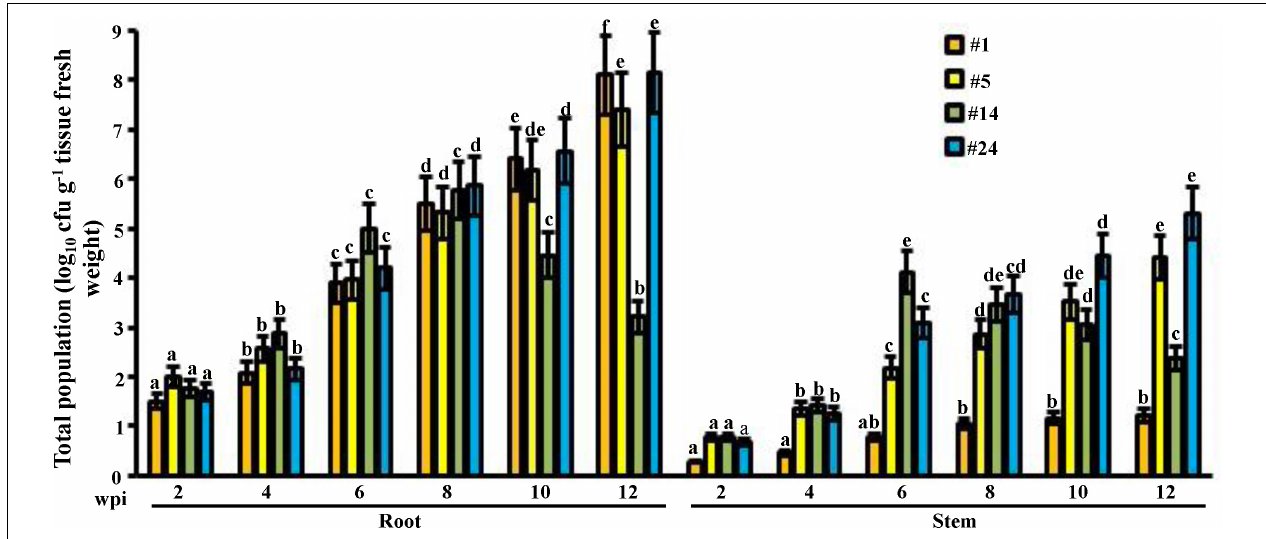
FIGURE 2 | Total population of the promising endophytic actinobacteria in mangrove tissues. Population density of the endophytic PA-non-producing isolate #5 and PA-producing isolates #1, #14, and #24 in the root and stem of gray mangrove grown under greenhouse conditions. Tissues were sampled every 2 wpi. Values are means of eight replicates ± SE for each sampling per treatment. Mean values followed by different letters are significantly ( P < 0.05) different from the total populations of each strain in that particular tissue according to Fisher’s protected LSD test. Isolate #24 represents the endophytic PA-producing Streptomyces mutabilis UAE1. PA, polyamine; wpi, weeks post